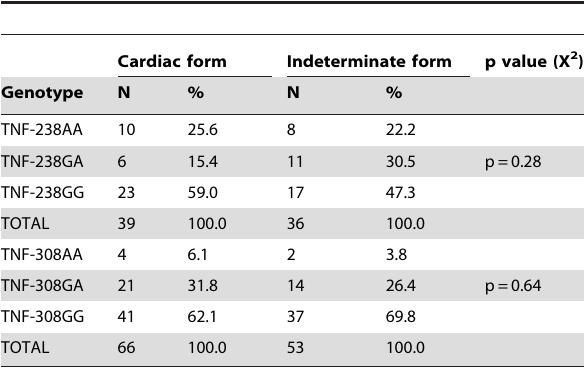
Table 3. TNF-alpha genotypes found in subjects from an endemic area according to clinical form.